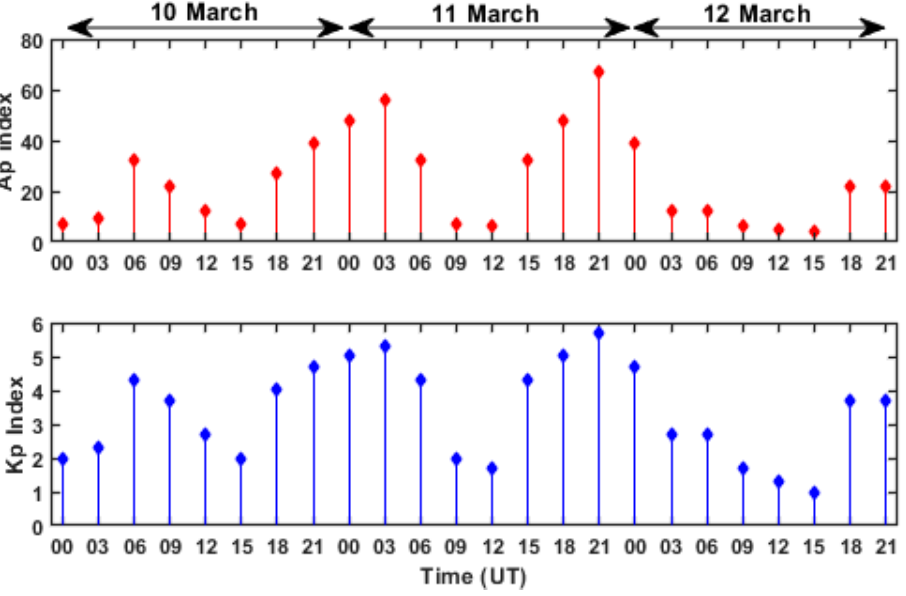
Figure 3. Geomagnetic conditions during 10–12 March